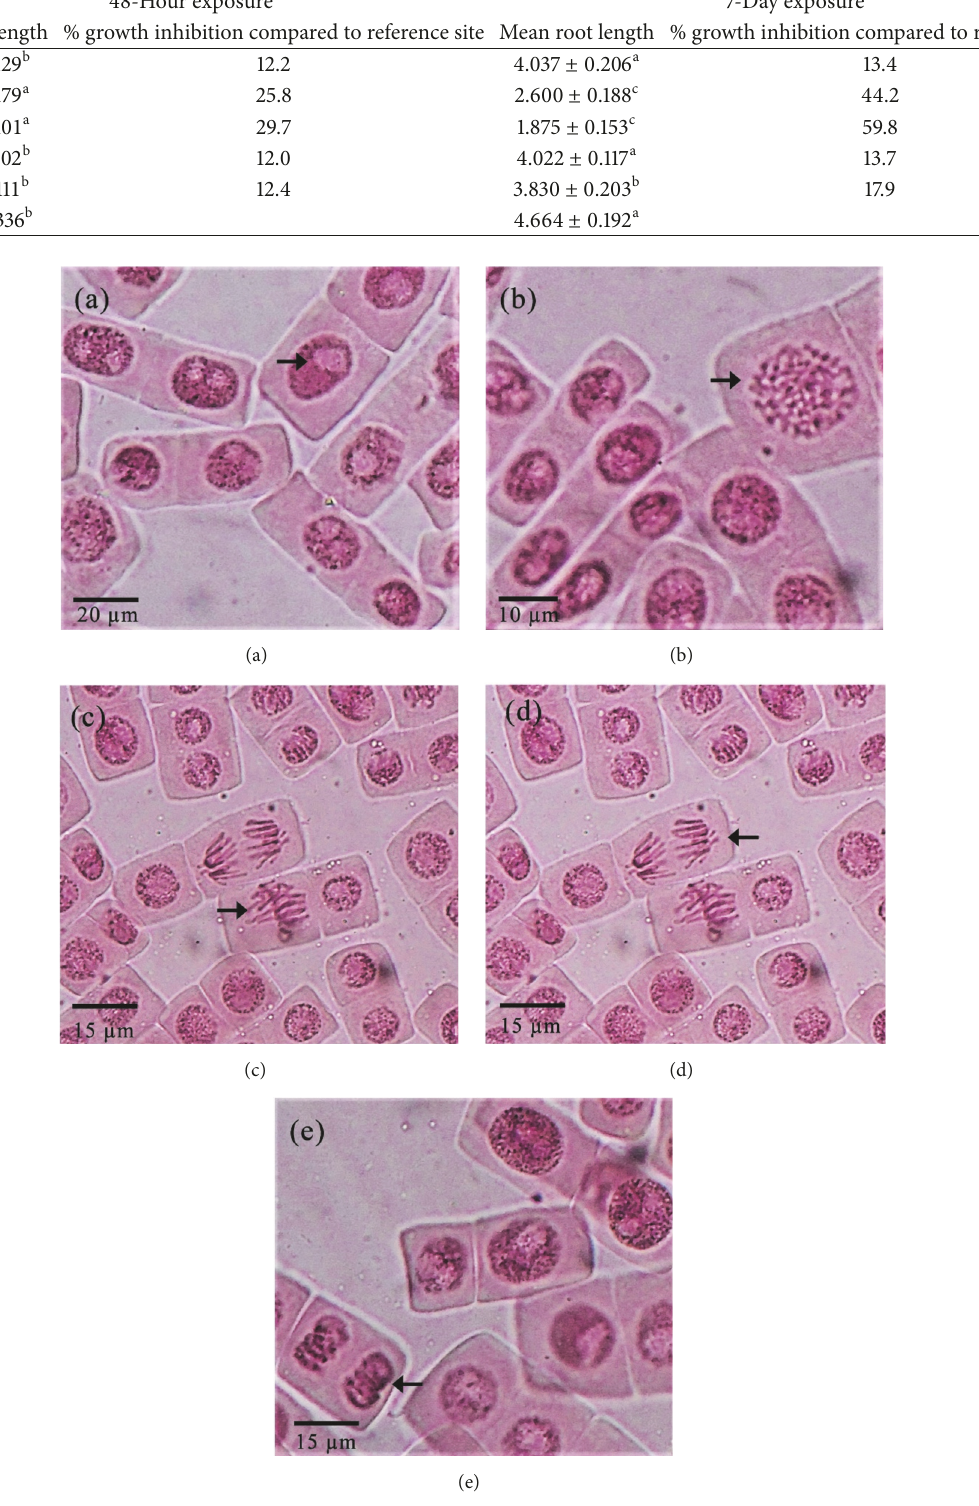
Figure 2: The microscopic appearance of normal interphase cells and dividing cells in the Allium. cepa root tip meristematic region ((a): Interphase; (b): Prophase; (c): Metaphase; (d): Anaphase; (e):